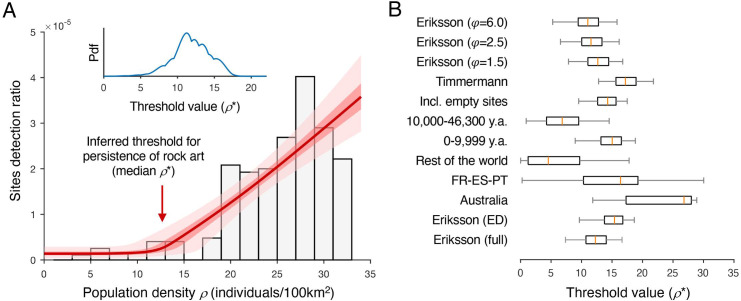
Empirical support for the epidemiological model.A. Inferred detection ratios given the epidemiological model, the full archaeological dataset, and the combined population estimates from [35,36] (see Methods). Grey bars: Empirical rock detection ratios for different intervals of population density. Red line: Estimated rock art detection ratio as a function of population density (median of posterior distribution of estimated detection ratio, with interquartile range in dark pink and 95% CI in pale pink). The red arrow on the main axis shows the most likely values of the inferred threshold, i.e., the median of the posterior probability density function (pdf) shown in the inset). B. Inferred values of the critical threshold for the different analyses described in the paper (FR-ES-PT: France-Spain-Portugal; ED: exact direct; orange line: maximum likelihood estimate; box: interquartile range; whiskers: CI 0.025–0.975).